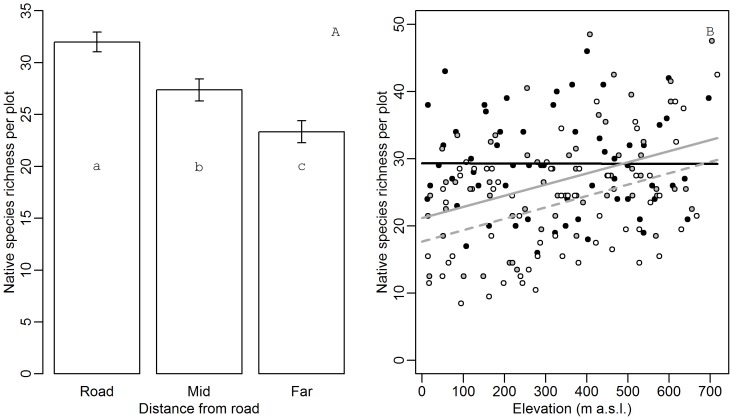
Native species richness as a function of elevation and distance to the road.(A) Average native species richness (±1 SE) in plots across the elevational gradient. Different letters indicate significant differences (p<0.05) in a Tukey’s post-hoc test. (B) Native species richness (number of species per plot) as a function of elevation. •, black full line: roadside plots; •, grey full line: mid plots; ○, broken line: far plots (see Fig. 1 for plot types).